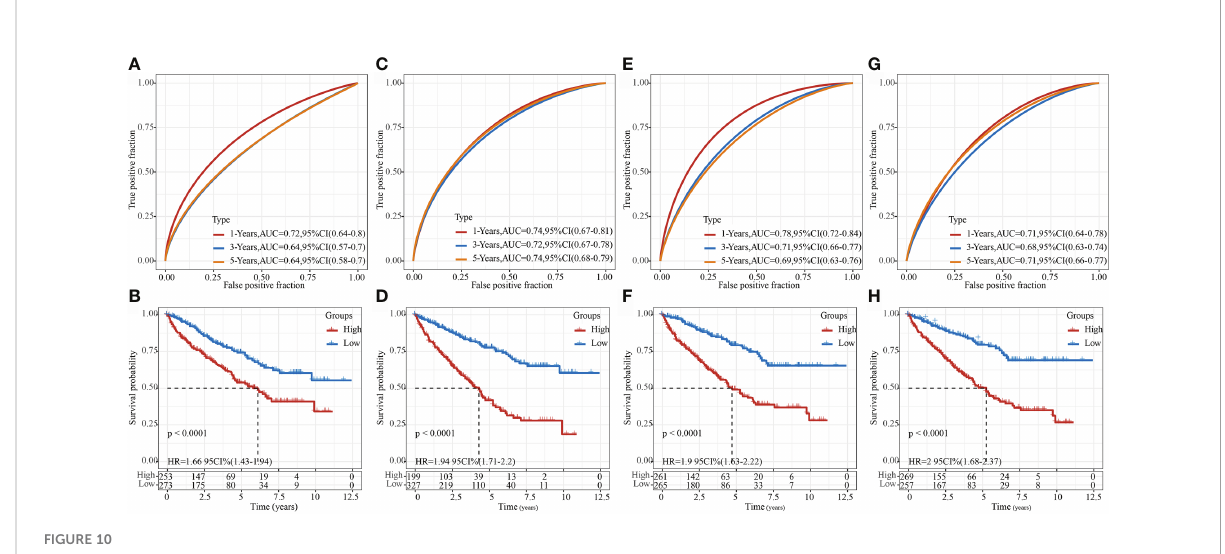
FIGURE 10 Comparison of our risk model with other models. (A) ROC of 9-gene signature (Zhong) risk model. (B) KM curve of 9-gene signature (Zhong) risk model on high- (n = 253) and low-group (n = 273) samples; (C) ROC of 7-gene signature (Jiang) risk model. (D) KM curve of 7-gene signature (Jiang) risk model on high- (n = 199) and low-group (n = 327) samples; (E) ROC of 7-gene signature (Chen) risk model. (F) KM Curve of 7-gene signature (Chen) risk model on high- (n = 261) and low-group (n = 265) samples; (G) ROC of the 6-gene signature (Ren) risk model. (H) KM curve of 6-gene signature (Ren) risk model on high- (n = 269) and low-group (n = 257)